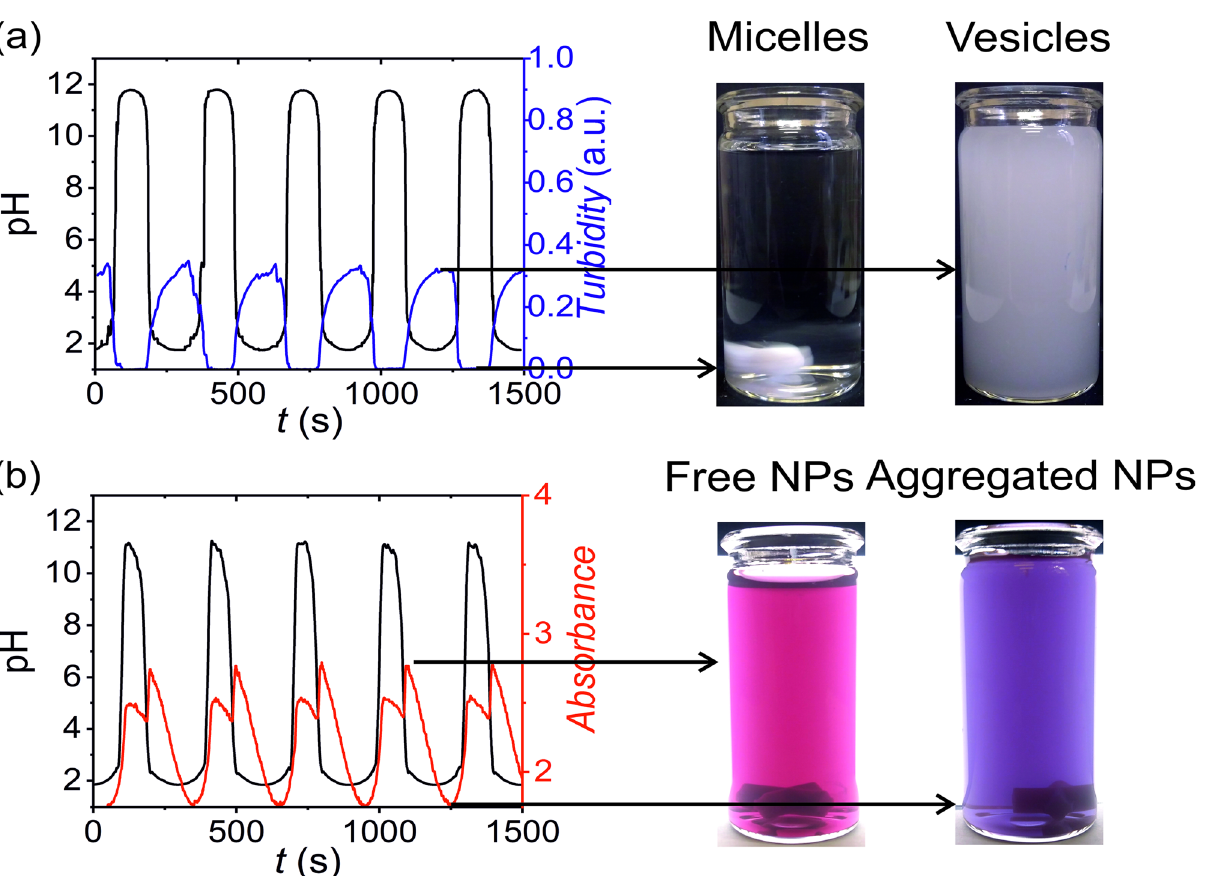
Figure 5. Reversible transformation of vesicle and micelles ( a ) and assembly/disassembly of pH-sensitive AuNPs ( b ) using the non-autonomous pH oscillator (sinusoidal function, ϕ = π, T acid = T base = 300 s ). The concentrations of the acid and alkaline solutions in the input feed were 0.1 M ( c